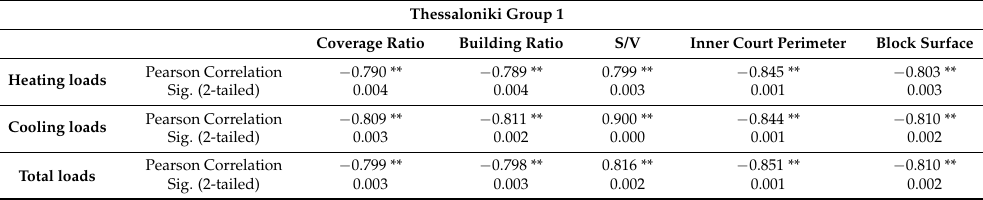
Table 8. Correlation of the form parameters to the load demand of the urban blocks of group 1 for the climate of